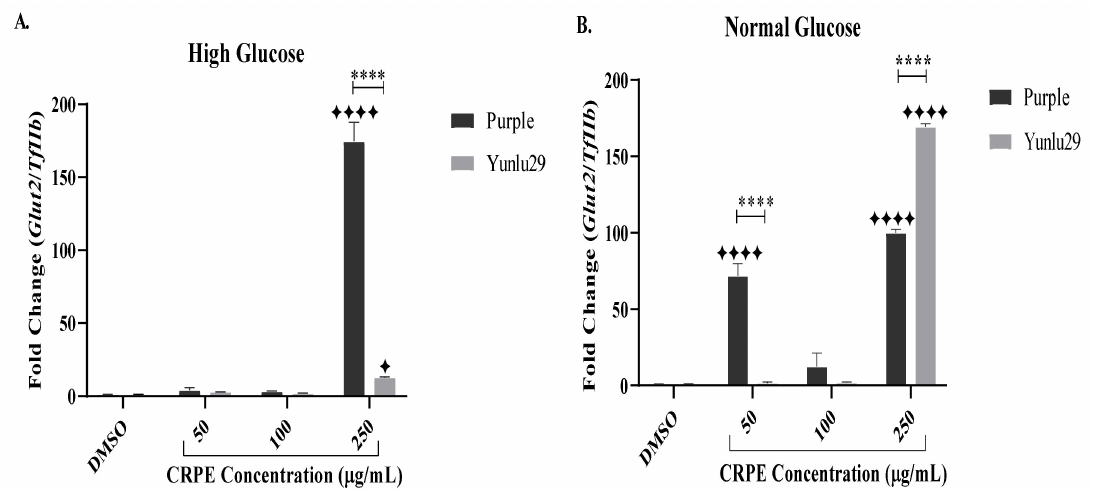
Figure 2. Expression of Glut2 in INS-1E cells. A ) high glucose (25 mM). B ) normal glucose (11.1 mM). n = 3. Stars indicate significant di ff erences between extracts and DMSO, where (cid:70) p < 0.05, (cid:70)(cid:70)(cid:70)(cid:70) p < 0.0001. Asterisks indicate significant di ff erences between the CRPE extracts, where, **** p < 0.0001; two-way ANOVA with Turkey’s multiple comparison post hoc test. Data is presented